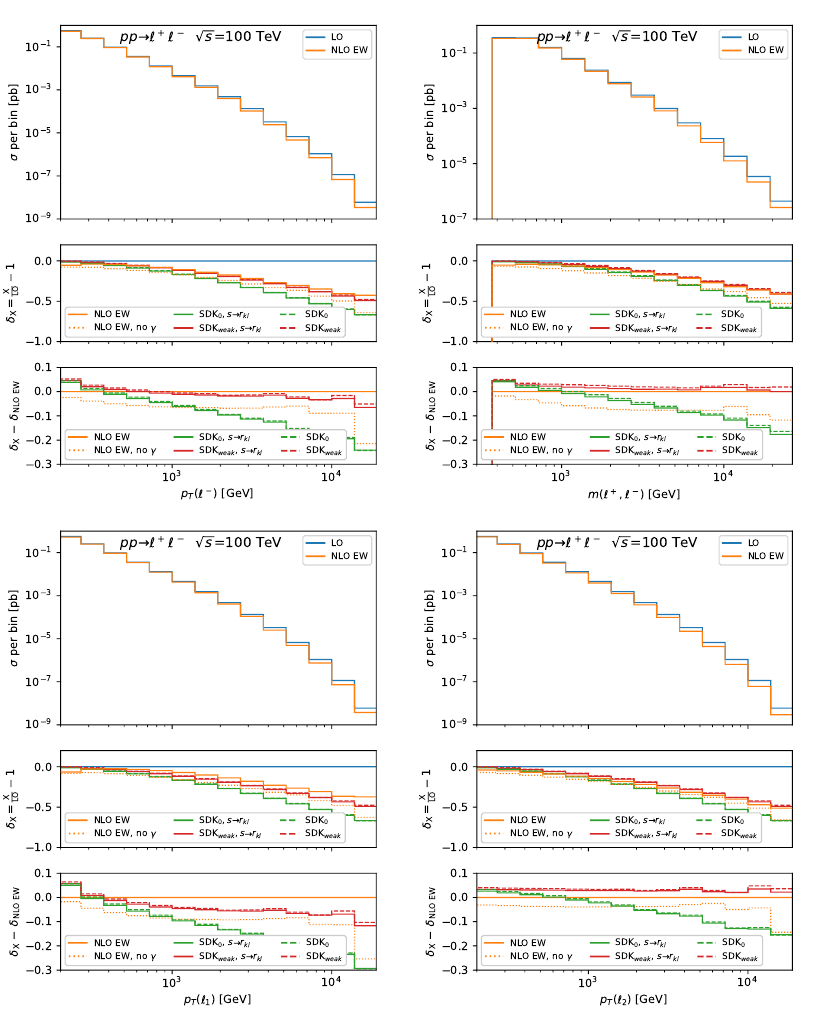
Figure 5 . Differential distributions for recombined leptons in Drell-Yan production at 100 TeV. Comparison between exact NLO EW predictions (solid orange) and their LA approximations in the SDK weak (red) and SDK 0 (green) approaches, including (solid) or excluding (dashed) the SSC s ! r kl terms. More details are given in the